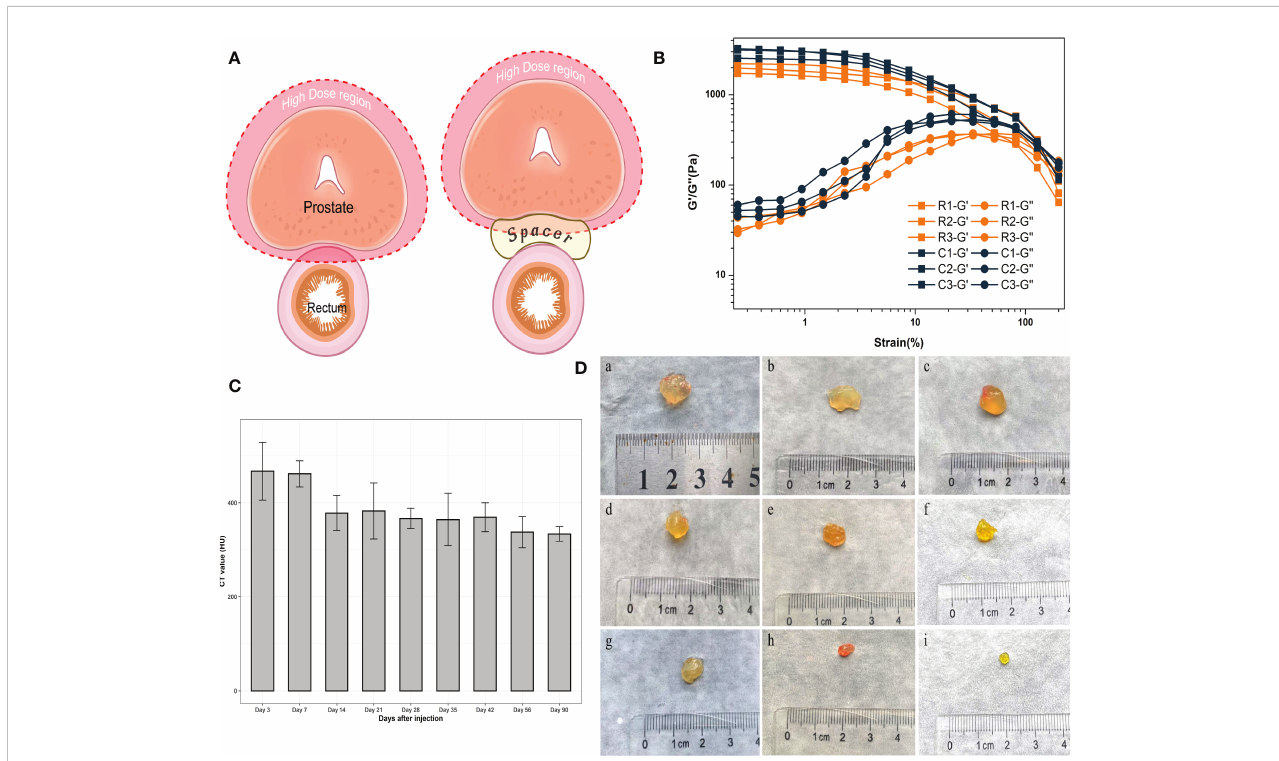
FIGURE 1 (A) The application of the spacer in radiotherapy for prostate cancer. (Created with BioRender.com.) (B) Rheology study of hydrogels exposed in radiation. (C) CT values of hydrogels. (D) Residual hydrogels obtained from rats; “ a ” to “ i ” represent 3, 7, 14, 21, 28, 35, 42, 56, 90 days after injection,